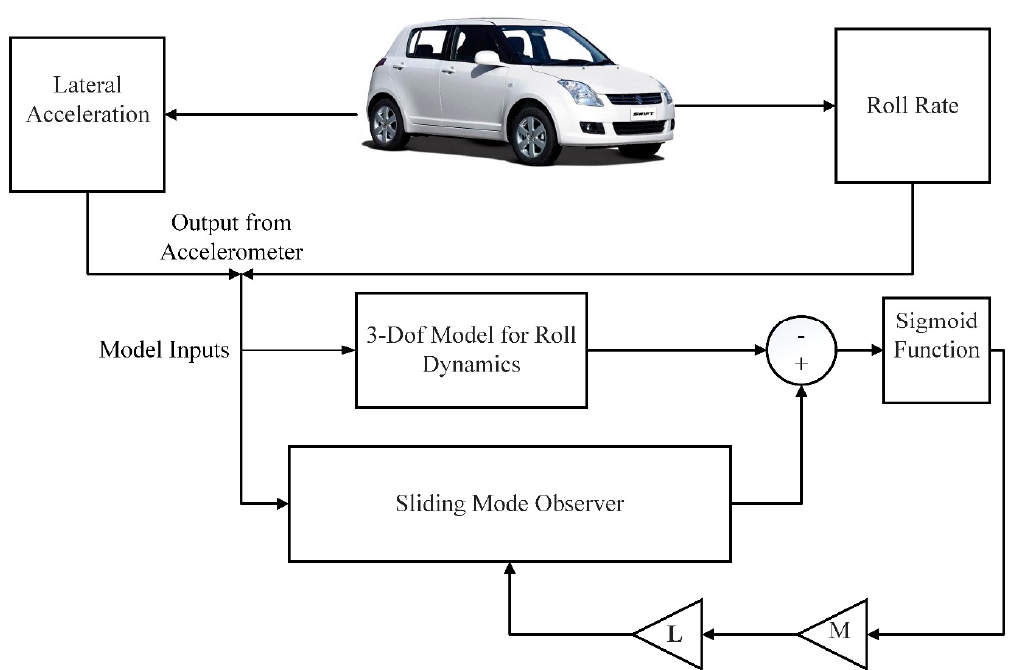
Figure 5. Sliding Mode Observer Estimation Process .